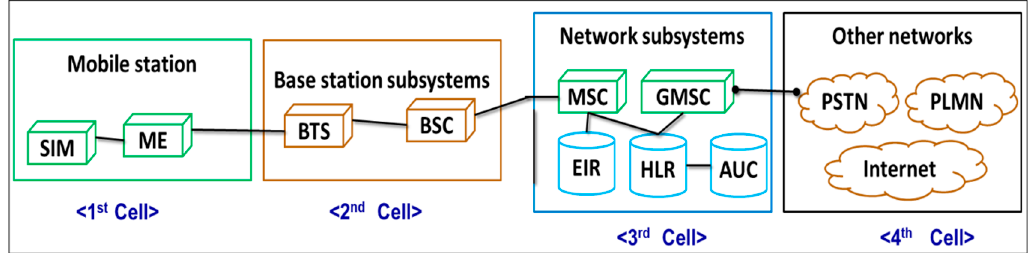
Figure 7. A detailed architecture of the GSM (group special mobile) network (example of the graphs based modelling of GSM).